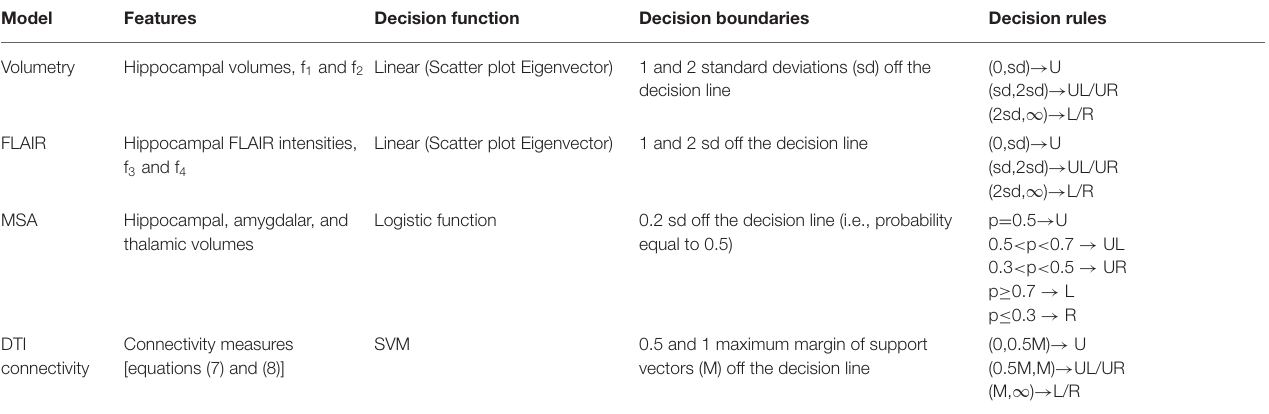
TABLE 2 | Definition of decision boundaries and rules for single modality